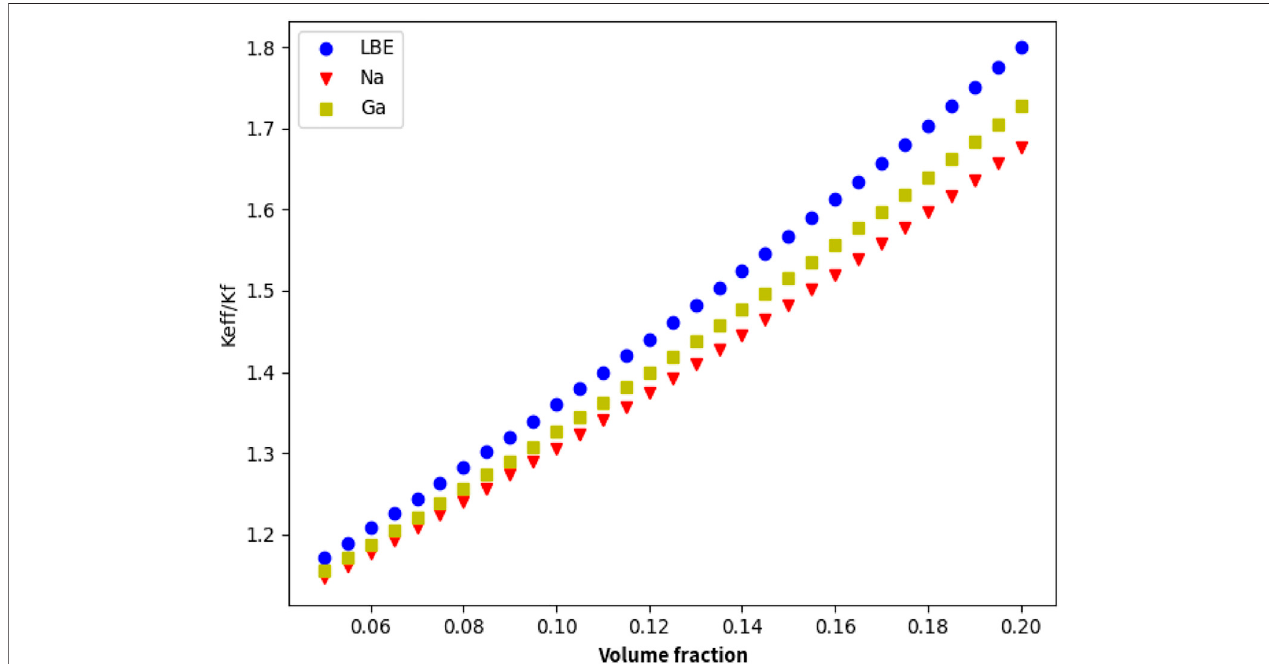
FIGURE 4 | Thermal conductivity changes with nanoparticle concentration ( T (cid:2) 600 K, r (cid:2) 20 nm).